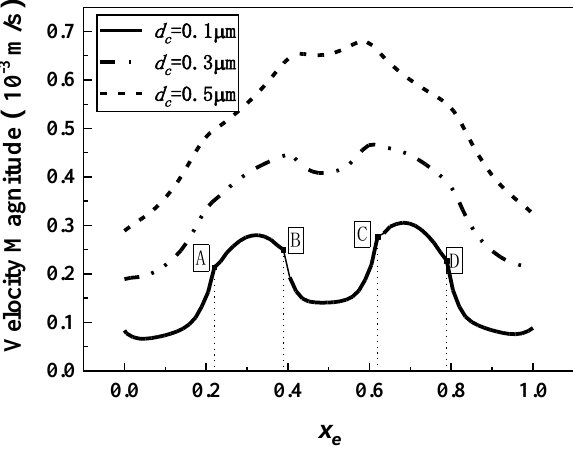
Figure 7. Velocity distributions at different measuring heights under microbes.